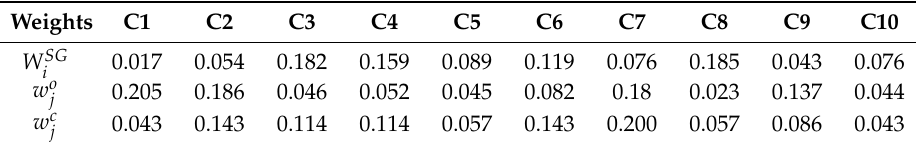
Table 17. Combination weights of the evaluation criteria.